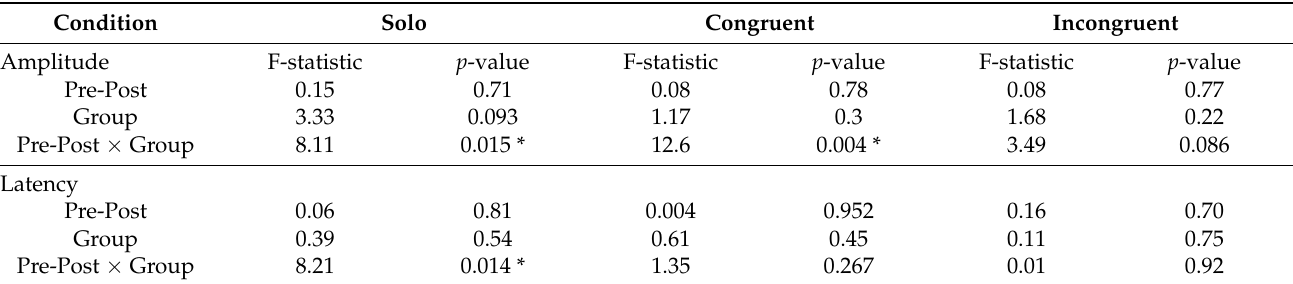
Table 4. ANT ERP statistical analysis